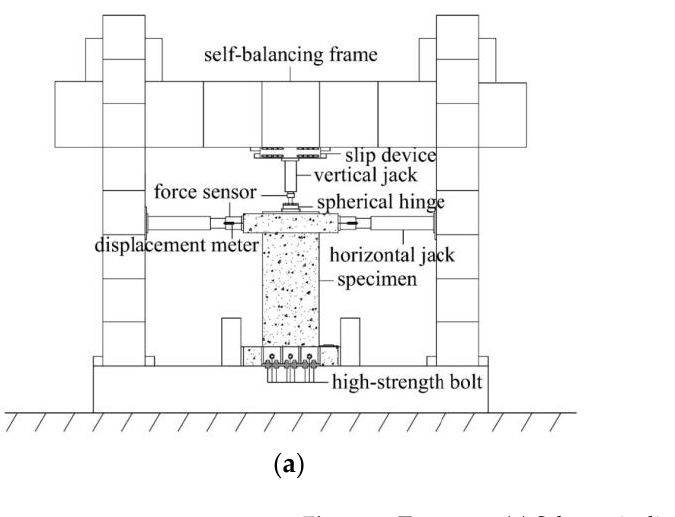
t / s Figure 5. Test loading protocol diagram. Table 5. lateral cyclic loading protocol. Loading Step